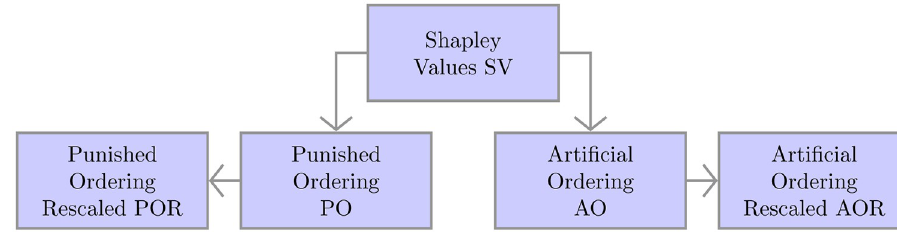
Fig 1. Genealogical tree of the penalties’